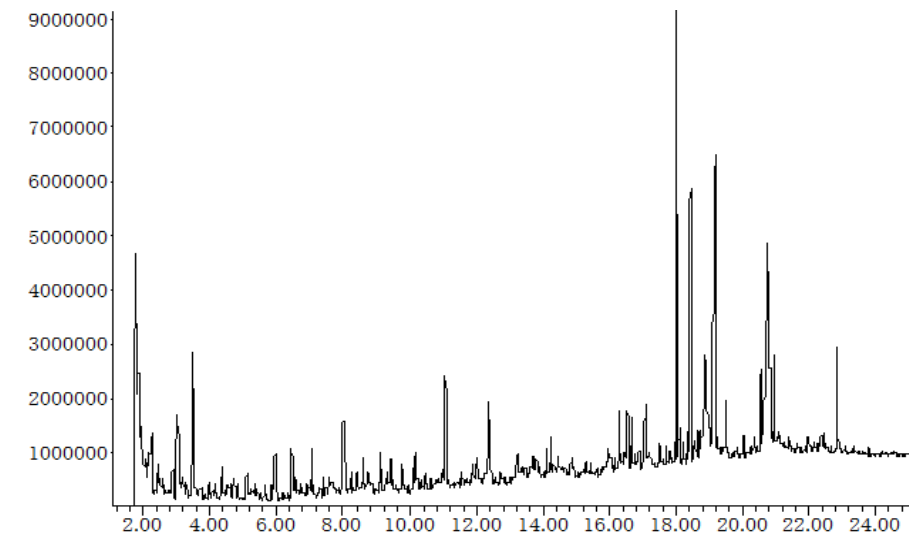
Figure 4. Gas chromatography (GC) profiles of pyrolytic products of microalgae. Table 4. Pyrolysis-gas chromatography/mass spectrometry (Py-GC/MS) analysis of microalgae C. vulgaris .